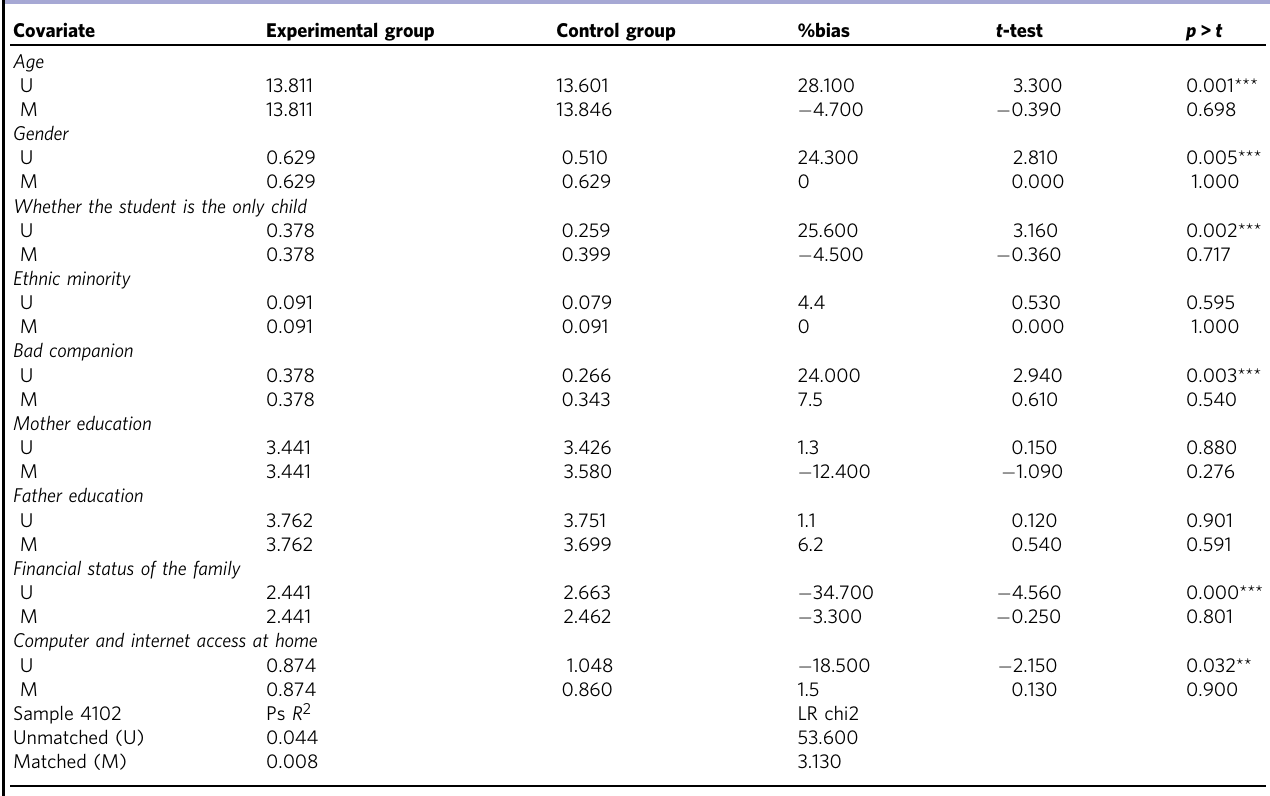
Table 5 Matching balance test on the model of only mother migrates.